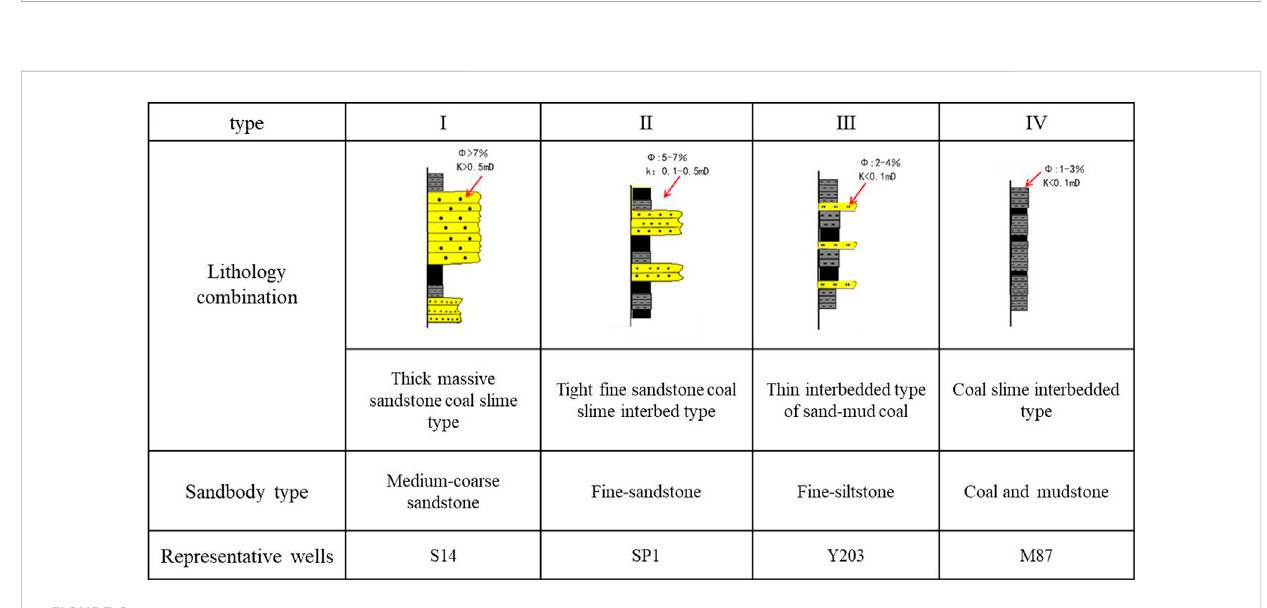
coal measure gas in this paper, excluding the coal measure tight sandstone gas in current exploration and exploitation, speci fi cally refers to the unconventional self-sourcing natural gas stored in coal beds, shale, and fi ne siltstone.